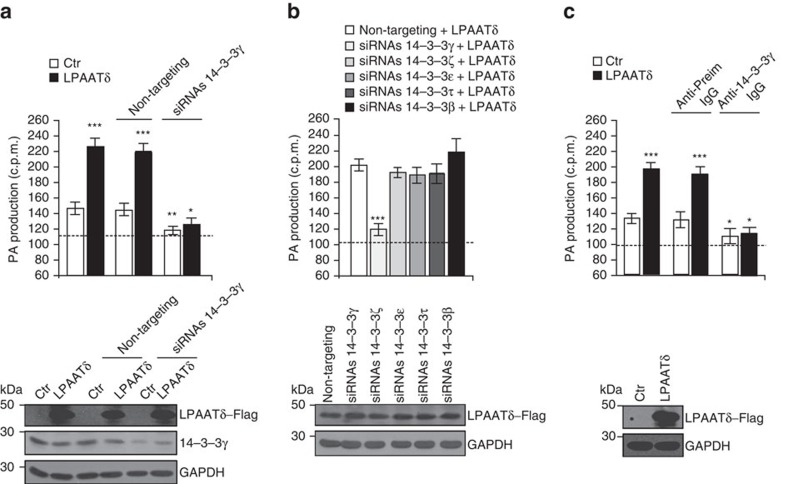
14-3-3γ but not other 14-3-3 isoforms is required for LPAATδ activity.(a–c) Quantification of phosphatidic acid (PA) production in the LPAAT assay for post-nuclear supernatants from HeLa cells transfected with the empty Flag-vector (Ctr) or LPAATδ–Flag (LPAATδ) plus: (a) transfection with non-targeting siRNAs or 14-3-3γ siRNAs for 48 h (as indicated); (b) transfection with 14-3-3γ, ζ, ɛ, τ and β siRNAs for 48 h (as indicated); (c) treatment of the post-nuclear supernatant with an anti-14-3-3γ polyclonal antibody (Anti-14-3-3γ IgG) or anti-preimmune-IgG (Anti-Preim IgG, as control) for 30 min at 25 °C before the LPAAT assay. (a–c) The dashed line indicates the level of endogenous LPAAT activity not associated with LPAATδ (see text for details). Bottom: representative western blotting with an anti-Flag antibody in a–c, and with an anti-14-3-3γ monoclonal antibody in a to monitor the transfection of LPAATδ and the depletion of 14-3-3γ in the lysate used for LPAAT assay. Glyceraldehyde 3-phosphate dehydrogenase (GAPDH) is shown for the internal protein levels and molecular weight standards (kDa) are indicated on the left of each panel. Data are means±s.d. of three independent experiments. *P<0.05; **P<0.01; ***P<0.005 versus control (Student's t-tests). See also Supplementary Fig. 9 for 14-3-3s expression levels.